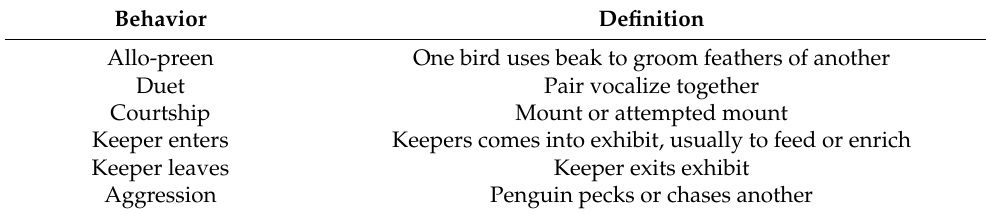
Table 3. Ethogram for Zoo Monitor. Behaviors recorded whenever they occurred during each 15-min observation period. In addition, the location of each penguin was noted on the map (Figure 1) every 1.5 min during each 15-min observation